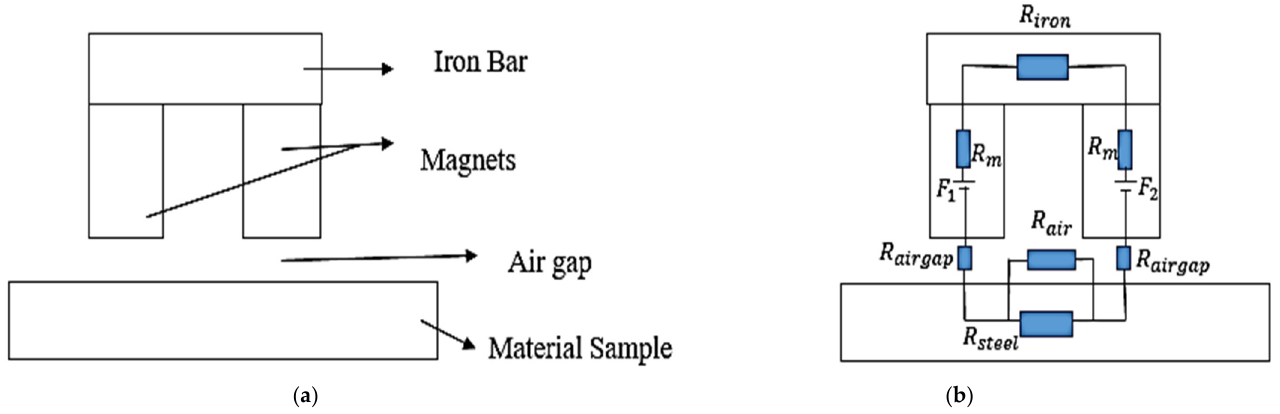
Figure 2. ( a ) The schematic representation of the magnetization yoke, and ( b ) the simplified equivalent magnetic circuit using lumped parameters reluctance network.